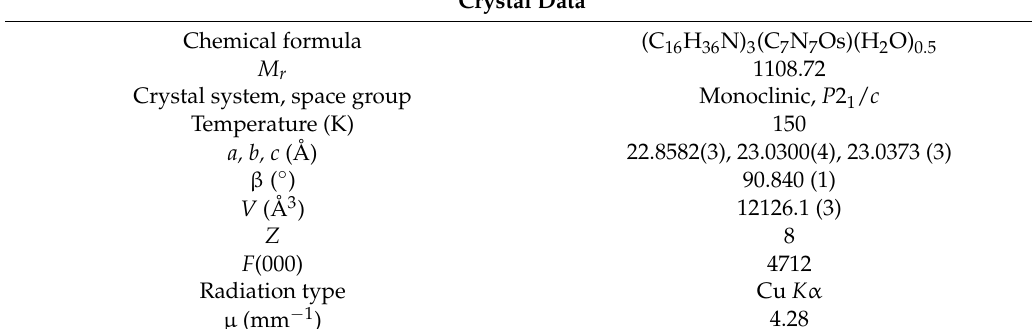
Table 1. Single-crystal X-ray diffraction analysis data and structure refinement parameters of 1 . Crystal